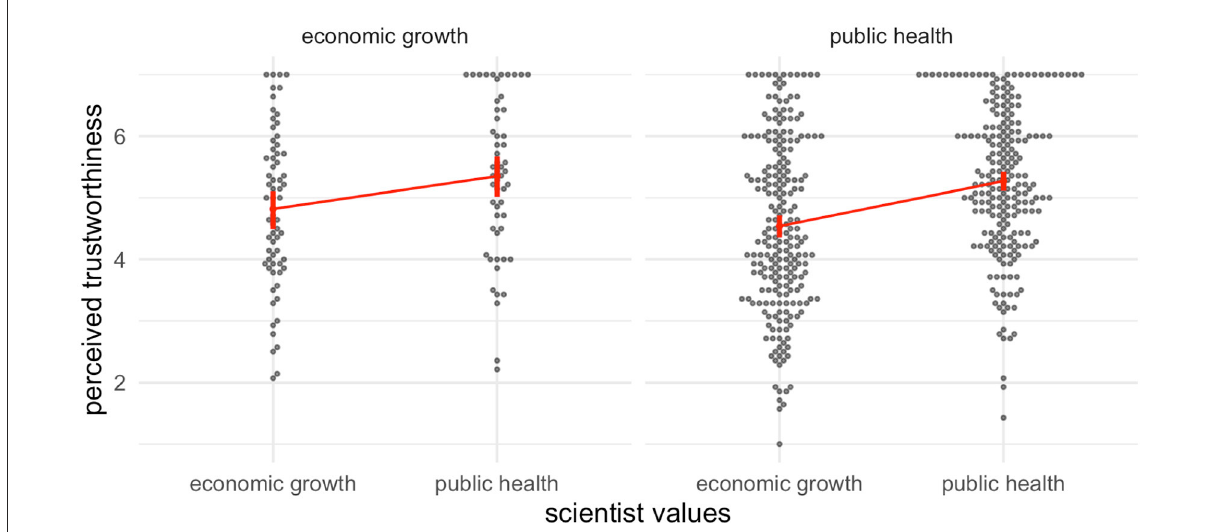
FIGURE6 Data, group means, and 95% confidence intervals for a potential interaction of scientist values and participant values. Panels correspond to participant values. This figure is identical to Figure 5, except the columns in the economic growth panel have been